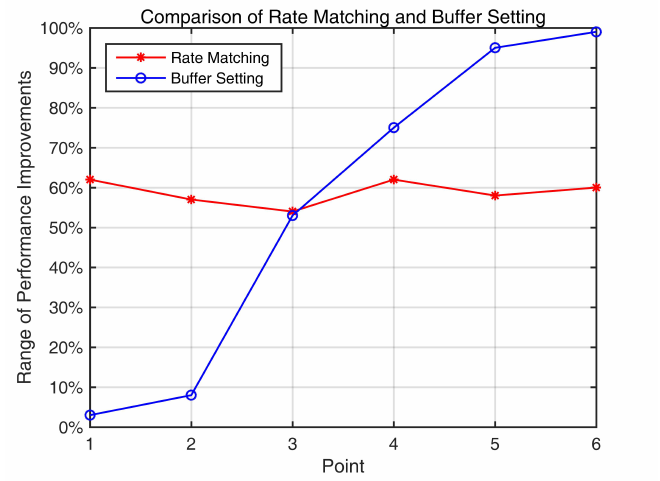
Figure 11. Simulation of rate